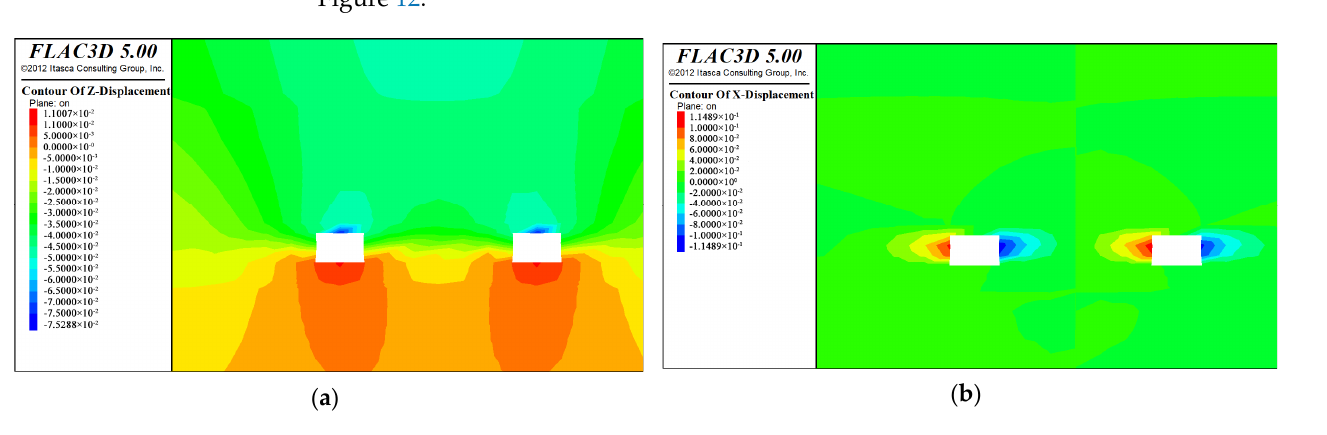
Figure 12. Displacement distribution of roadways after tunneling: ( a ) vertical displacement distribution; ( b ) horizontal displacement distribution.